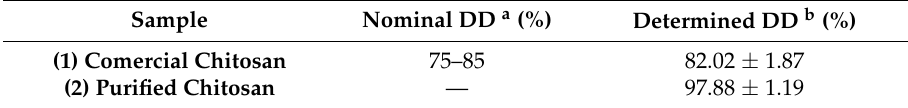
Table 1. Degree of deacetylation of the different chitosan samples used in this study ( n = 3).